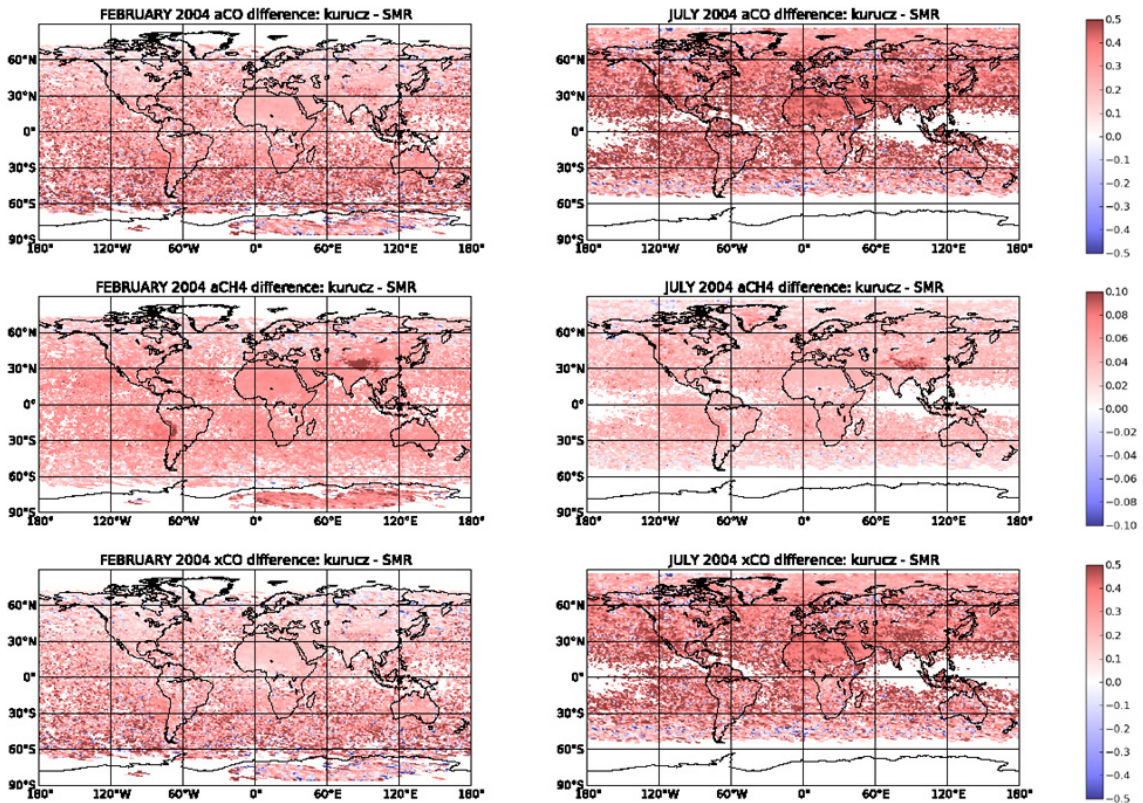
Fig. 8. Influence of the solar spectrum on monthly average CO retrievals. The plots show relative differences of α CO (top), α CH4 (mid), and xCO (bottom) of retrievals with the Kurucz solar spectrum vs. the SCIAMACHY SMR spectrum for two months in 2004: February (left) and July (right).